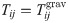
A) Map of the mobility fluxes T
ij between municipalities based on Twitter inferred trips (white). Infomap communities detected on the network T
ij are colored under the mobility fluxes (blue colors). B) Mobility fluxes T
ij between municipalities i and j are constructed by aggregating the number of trips between them. C) Correspondence between the observed fluxes T
ij and the fitted gravity model fluxes. Dashed line is the Tij=Tijgrav while the (blue) solid line is an conditional average of Tijgrav for values of T
ij. Maps were created using the maptools and sp packages in the R environment.